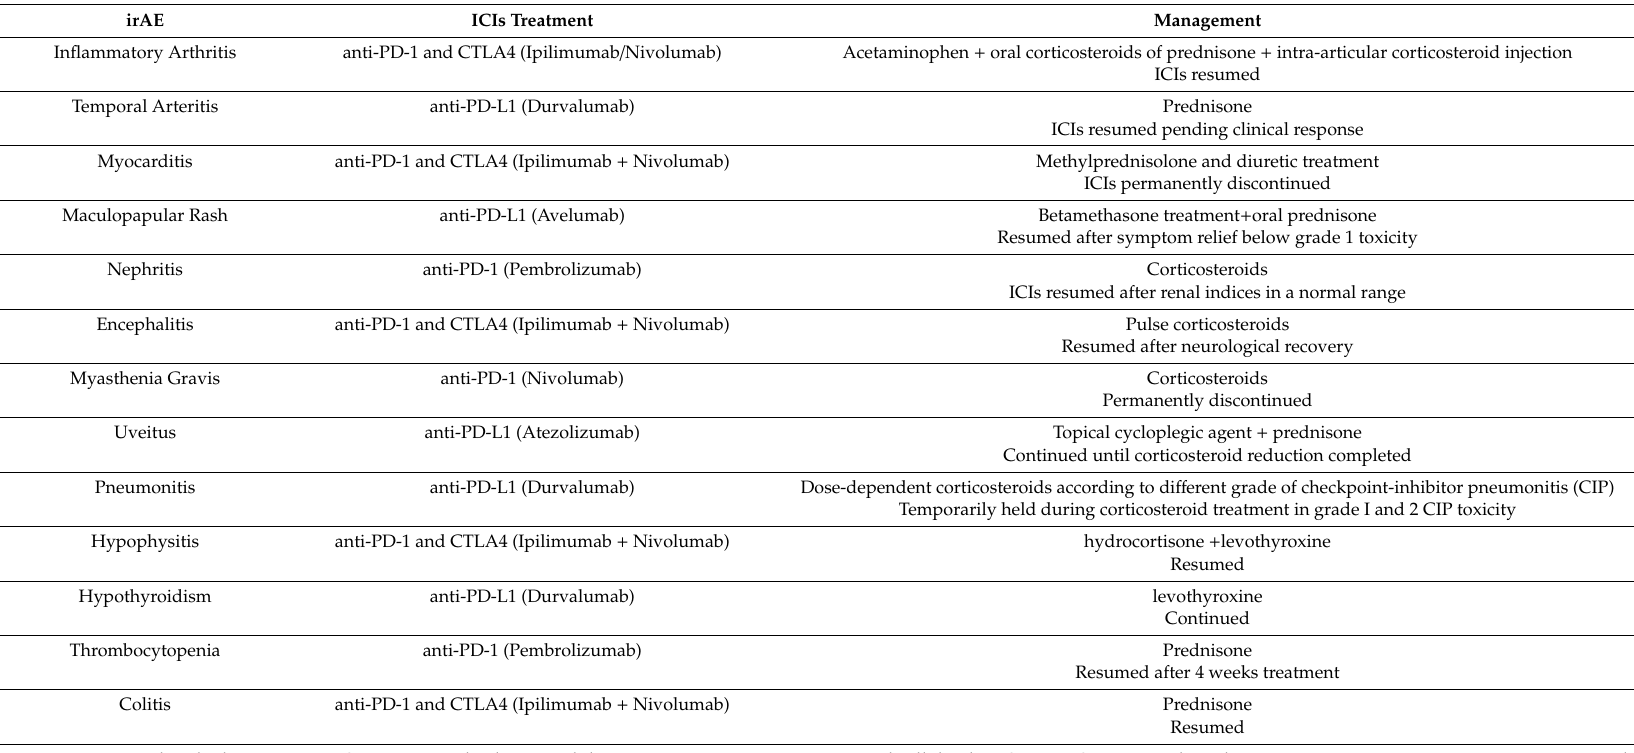
Table 2. Management of immune-related adverse events induced by immune-checkpoint